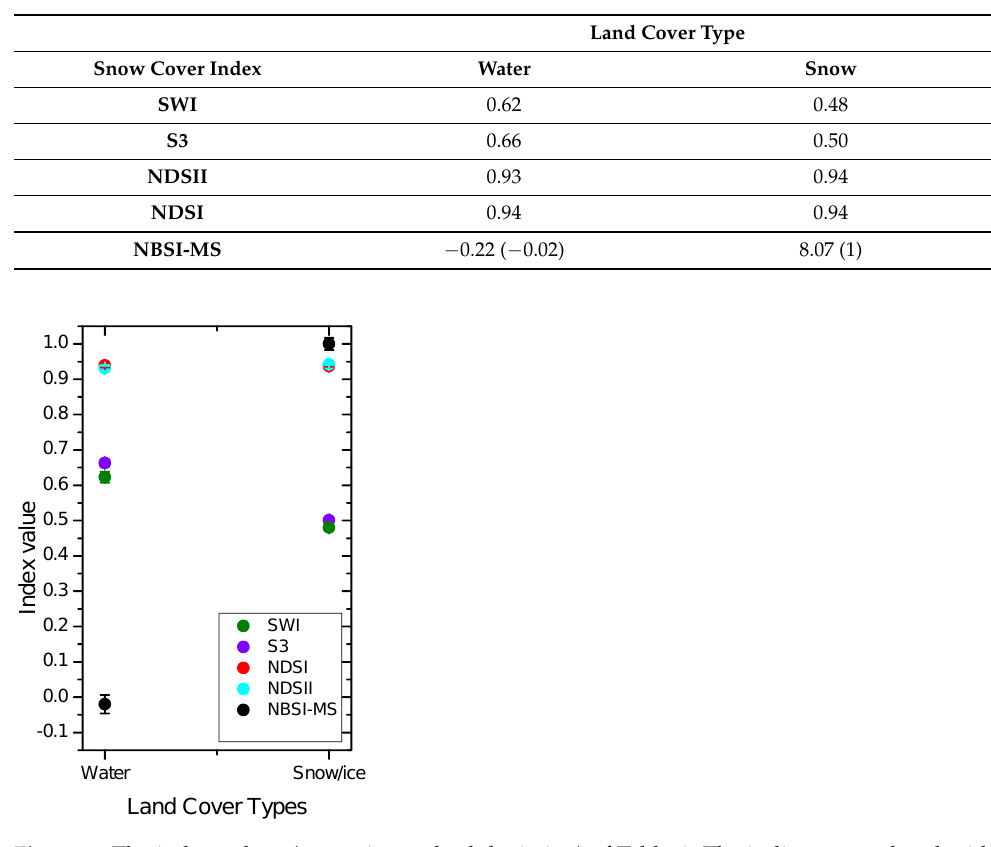
Figure 8. The index values (mean ± standard deviation) of Table 6. The indices are ordered with increasing snow index